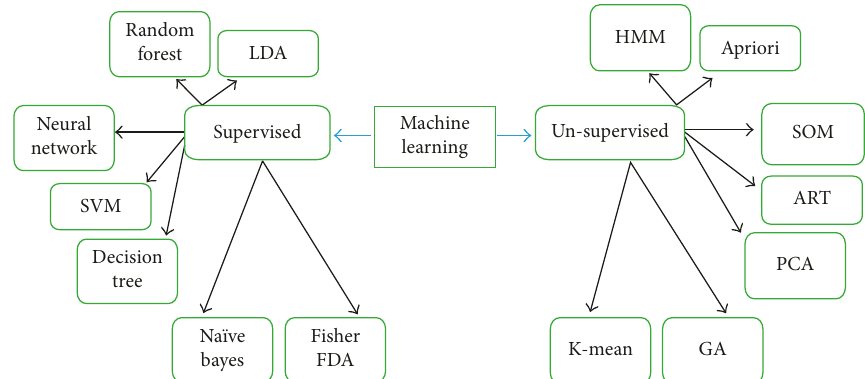
Figure 1: Supervised and unsupervised machine learning techniques.